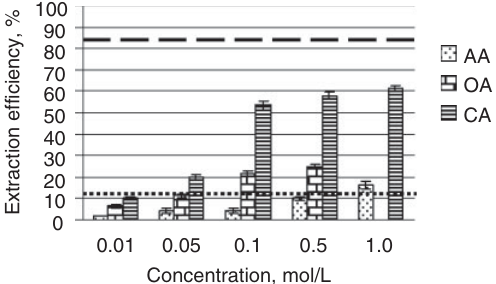
Fig. 4. The copper extraction efficiency (%) using various concentrations of organic acids: AA, acetic acid; OA, oxalic acid; CA, citric acid. Below the dotted line, the HM percentage in the mobile fractions (F1 (cid:3) F2); between the dotted and dashed lines, the HM percentage in the poten- tially mobile fractions (F3 (cid:3) F4); above the dashed line, the HM percentage in the immobile fraction